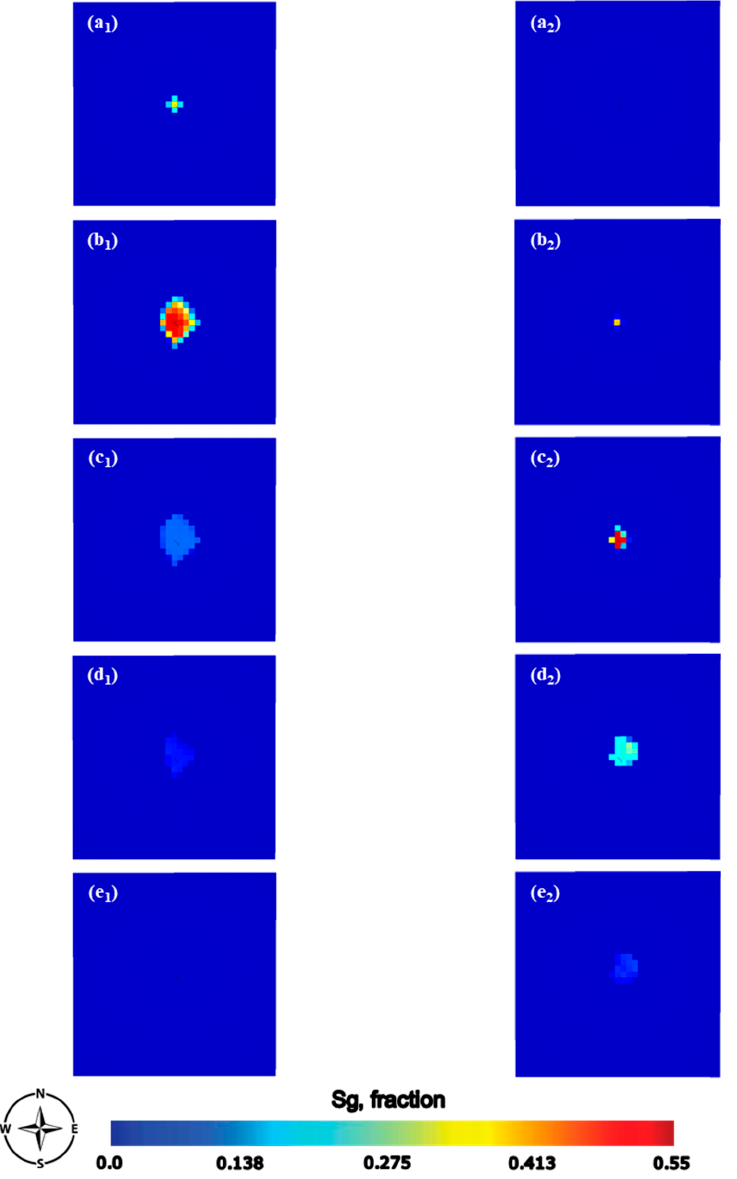
Figure 4. Plan view illustrations of simulated Sg evolution for the base case from the arkosic layer top view ( a 1 , b 1 , c 1 , d 1 , e 1 ) and homogenous case from the Upper Mt. Simon top view ( a 2 , b 2 , c 2 , d 2 , e 2 ) at ( a ) 1 year, ( b ) 30 years, ( c ) 100 years, ( d ) 1000 years, and ( e ) 10,000 years. Each figure’s size is 35 km × 35 km (x, During CO 2 injection, CO 2 propagates laterally in the high-permeability arkosic layer (Figure 3a 1 –b 1 ). By the end of CO 2 injection, the maximum CO 2 plume distance from the injection point is about 5 km laterally (Figure 4b 1 ). During post-injection, CO 2 continues